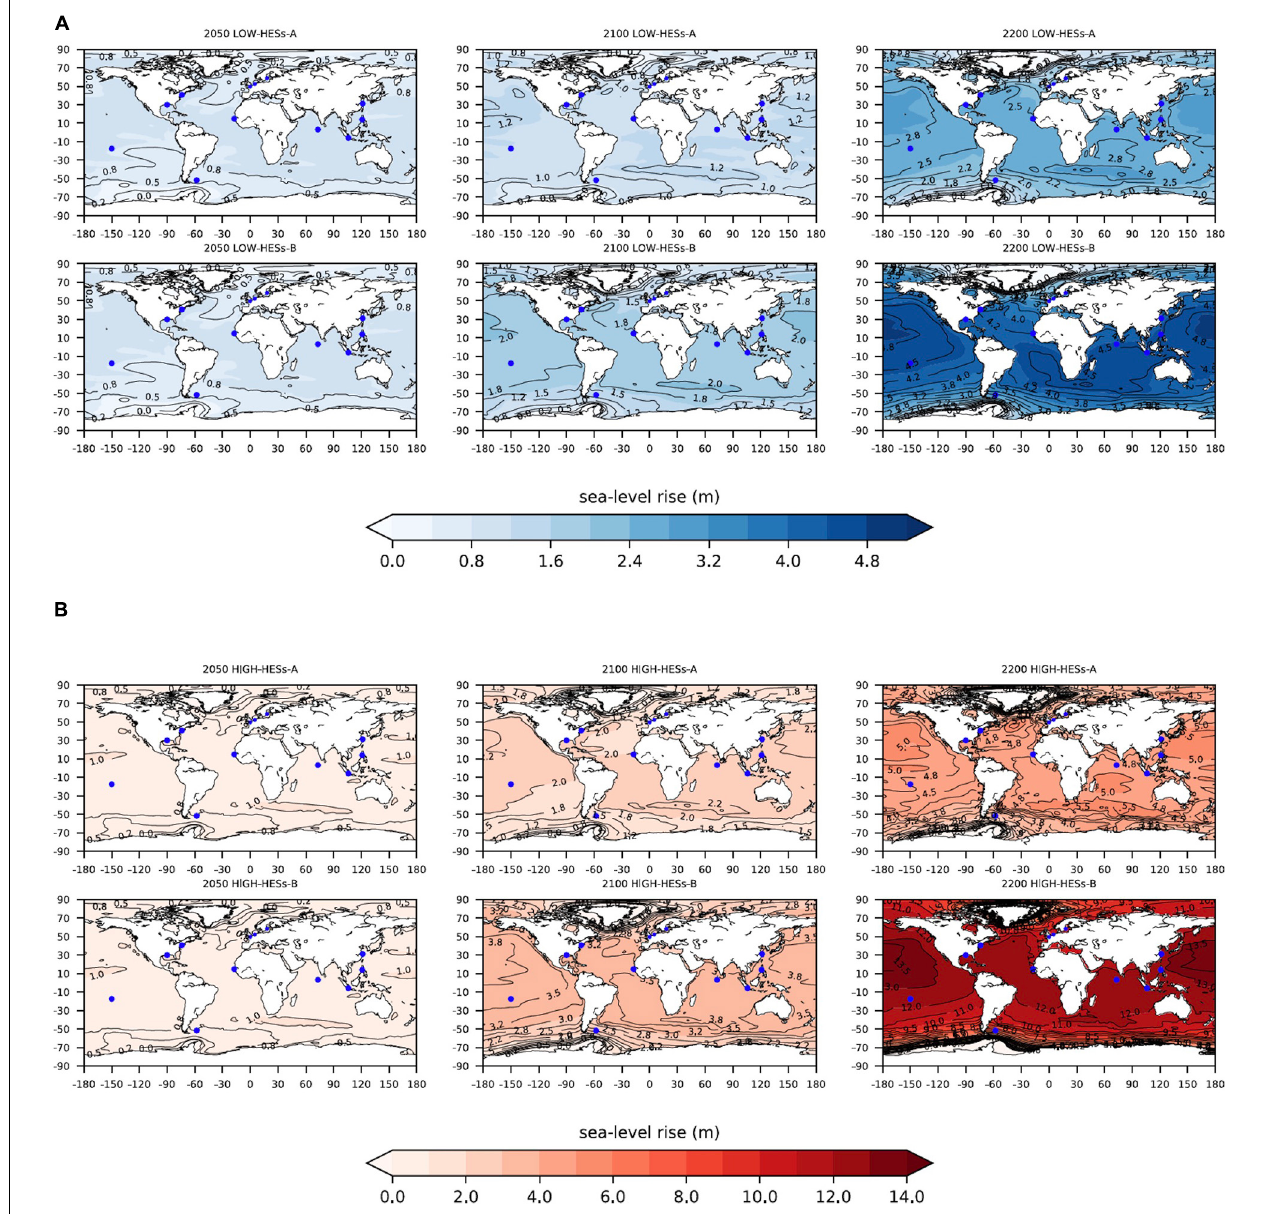
FIGURE 3 | HESs at global scale for (first row) HESs-A and (second row) HESs-B in (A) the low emission scenario and (B) the high emission scenario. Colors and contours display SLR (m) by (left) 2050, (middle) 2100, and (right) 2200 relative to 1986–2005. Blue circles represent the selected sites (refer to Figure 1 for the names) discussing from regional to local HESs.